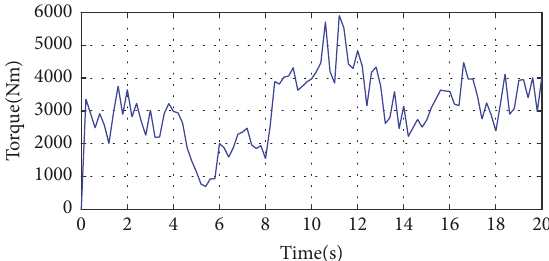
Figure 9: The equivalent wind force acting laterally on reflector.